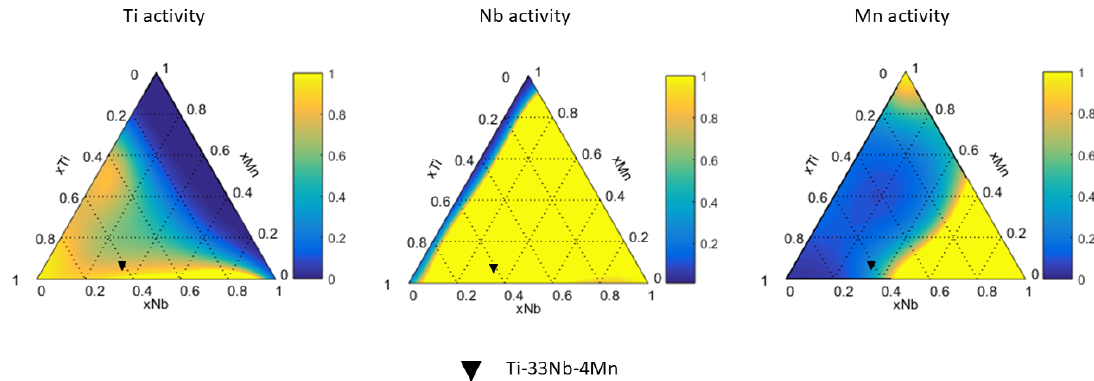
Figure 10. Ternary diagram of Gibbs free energy for the Ti ‐ Nb ‐ Mn system at 298 K.